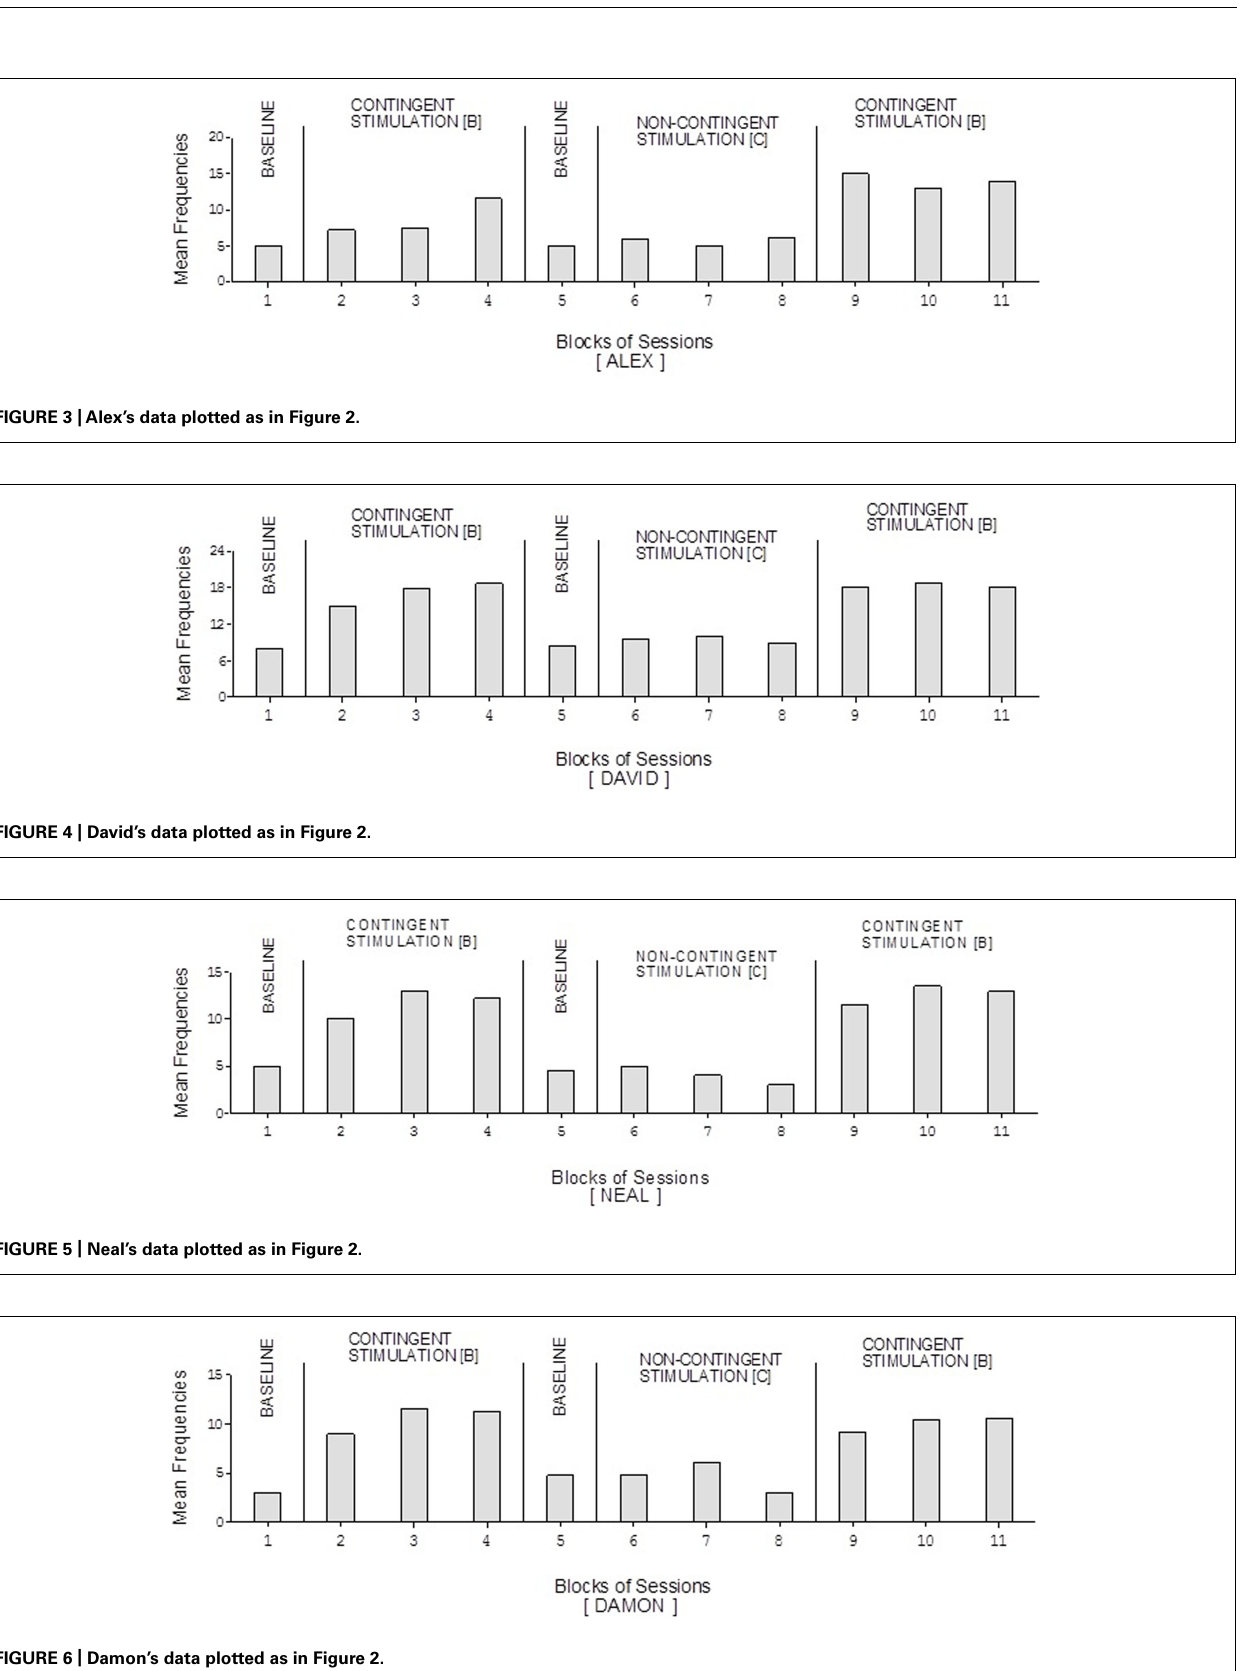
FIGURE 6 | Damon’s data plotted as in Figure